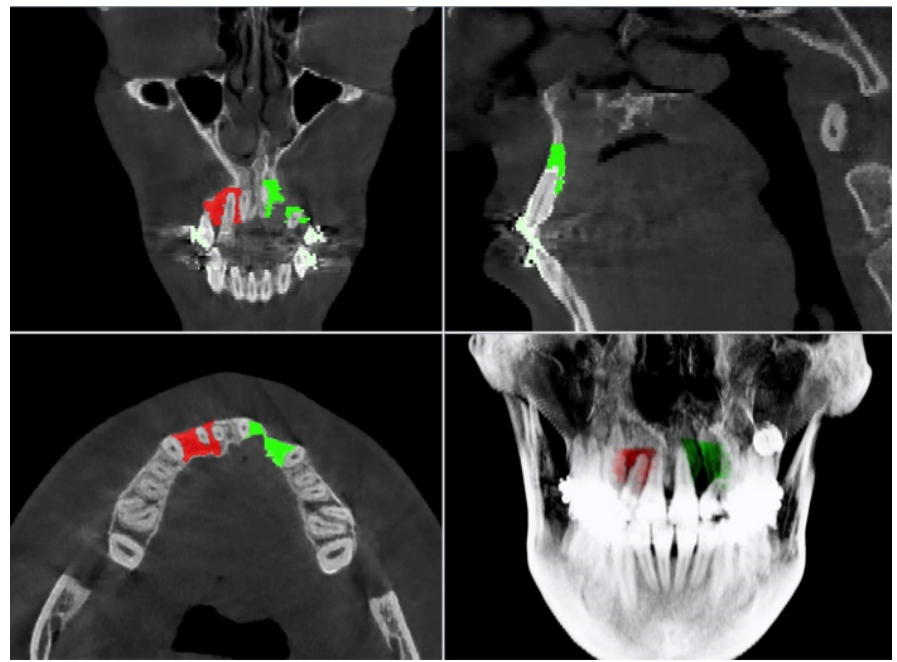
Figure 1. Multiplanar reconstructions with overlaid markings of cleft and non-cleft segmentation highlighted in green and red, respectively. The alveolar grafted bone area was traced on the horizontal computed tomography (CT) slices, using the drawing tools of VisNow software. The labial and palatal outline of bone localized between central incisor and canine were followed, excluding root of the lateral incisor if